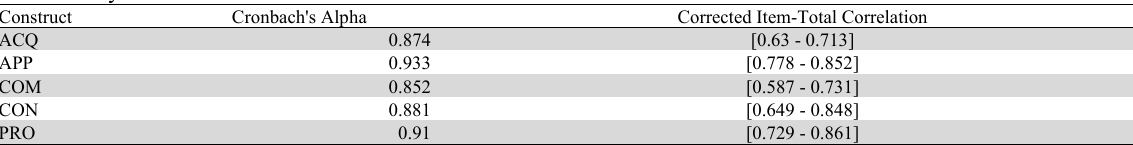
The reliability of measurement